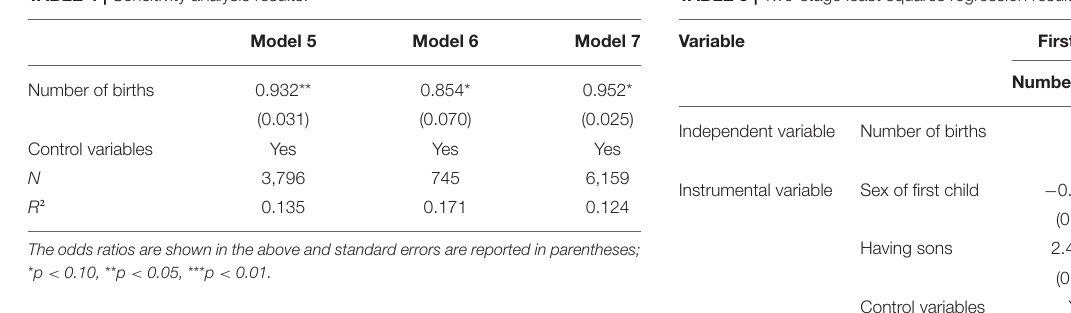
TABLE 4 | Sensitivity analysis results. TABLE 5 | Two-stage least squares regression